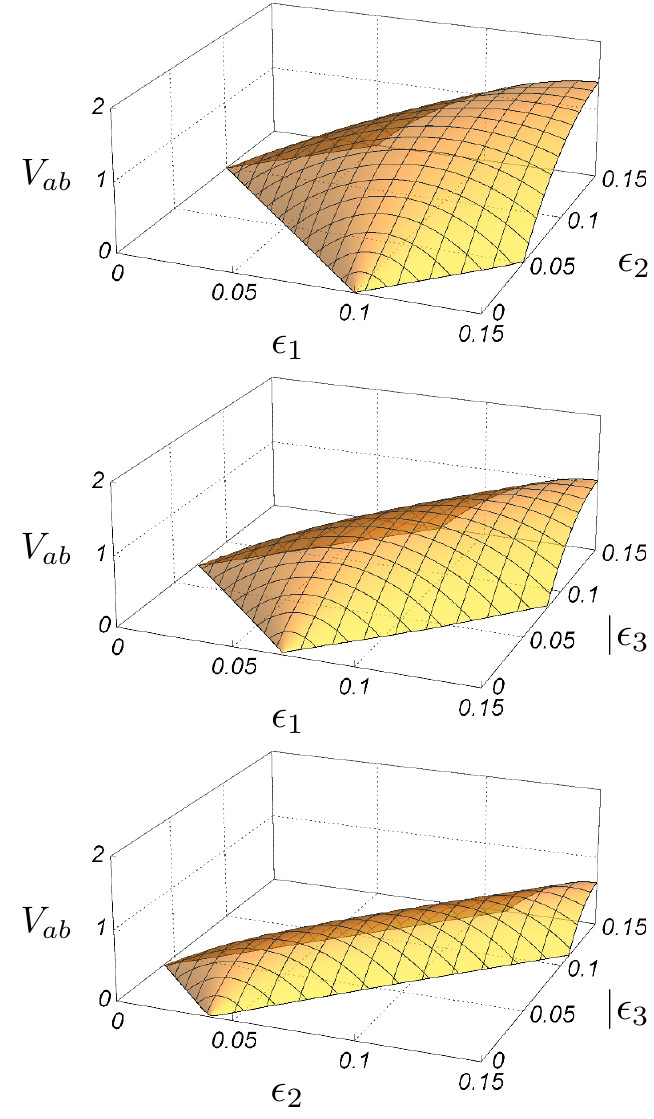
Figure 5 . One-loop potential V ab for three slices in the three-dimensional space of the volume moduli v i of the three 2-tori T 2 , with tan (cid:25)(cid:15) i 1 =v i . The slices are de(cid:12)ned by (cid:15) 3 = ^ (cid:15) 3 (top), i / (cid:15) 2 = ^ (cid:15) 2 (middle), and (cid:15) 1 = ^ (cid:15) 1 (bottom), where (^ (cid:15) 1 ; ^ (cid:15) 2 ; ^ (cid:15) 3 ) = (0 : 04 ; 0 : 07 ; 0 : 1) is a point in the (cid:0) tachyon-free region of moduli space. The potential (arbitrary units) is evaluated numerically for an ultraviolet cuto(cid:11) (cid:14) (cid:0) 1 = 10 3 and Pauli-Villars regulator masses (cid:22) 2 = 75, (cid:22) 2 = 25. 1 2 Wilson-line potential has no stable extrema and the system is therefore driven to the tachy- onic regime. For zero Wilson lines tachyon condensation takes place. This is interpreted as brane-brane recombination and it is expected that tachyon condensation restores super- symmetry, at least partially (see, for example, [34{36]). In the following, we shall address for the (cid:12)rst time tachyon condensation in a compact